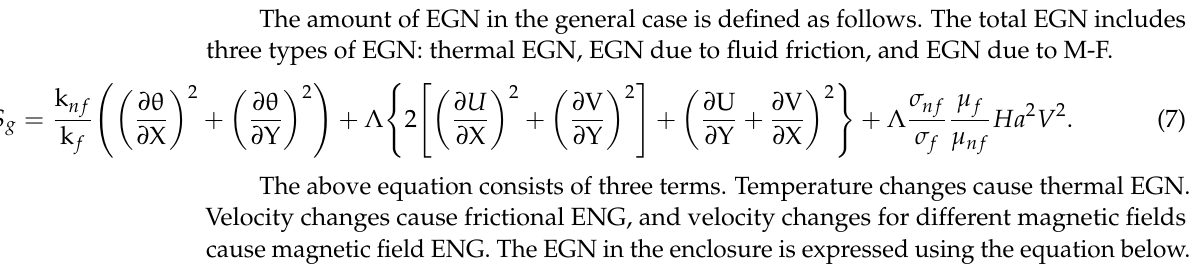
Figure A2. Dimensionless boundary Figure 2. Dimensionless boundary conditions.